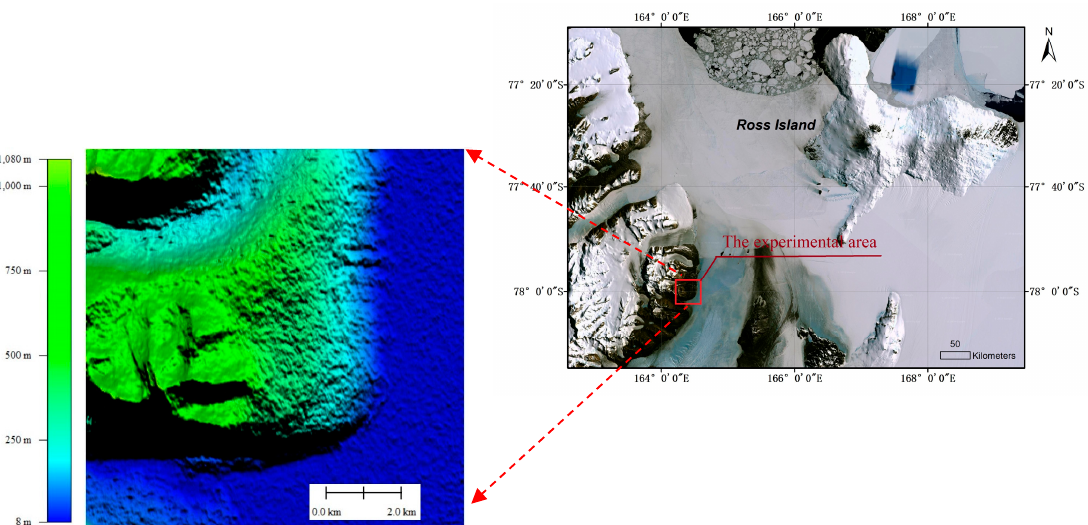
Figure 2. The experimental area in McMurdo Dry Valleys.